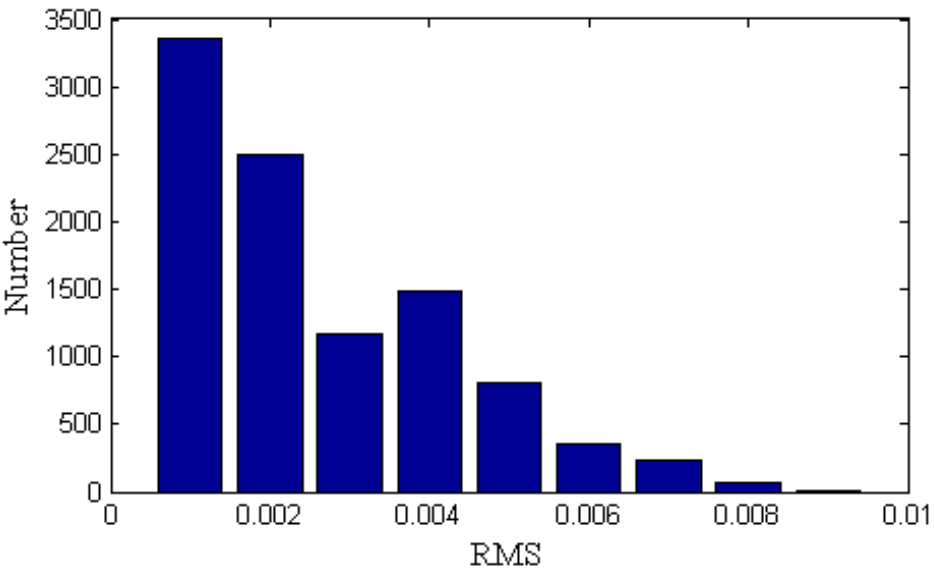
Figure 9. Histogram of the average RMS of external accuracy testing for the G Π model when compared with that from the GGOS data of 2014. Table 4. Statistical results: MAE and RMS for the G Π model across different latitude ranges in 2014.